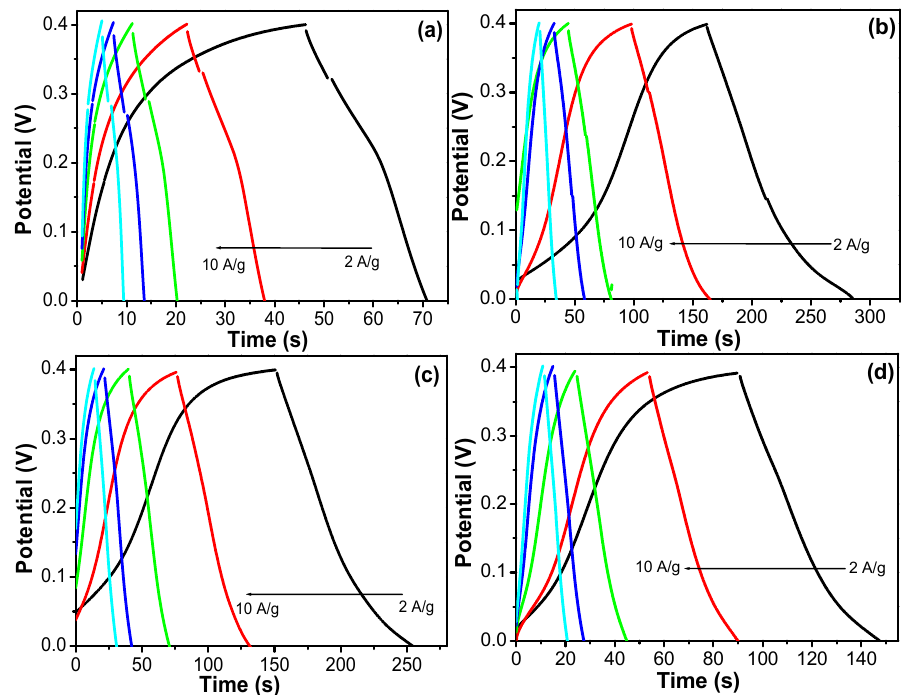
Figure 9. GCD curves of the ( a ) SiCo-1-16; ( b ) SiCo-1-26; ( c ) SiCo-1-36; and ( d ) SiCo-2-36 LDH electrodes at different current densities.